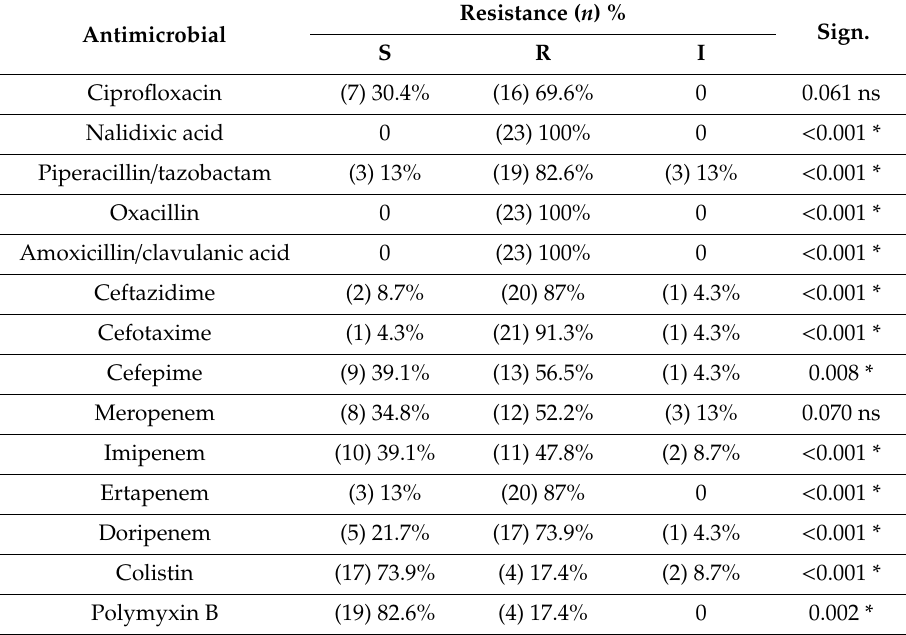
Figure 1. Random Amplification of Polymorphic DNA (RAPD) type, strain, source, carbapenemases, antimicrobial susceptibility, and MHT test of the 23 A. baumannii isolates. Individual isolates showing hierarchical clustering of isolates and factors. Binary factor (carbapenemase genes) indicated by presence (+) and absence (-); however, ordinal factor (antibiotics) indicating resistance by orange color, intermediate (yellow), and sensitive (green). Abbreviations: tobramycin (TOB), gentamycin (CN), amikacin (AK), norfloxacin (NOR), levofloxacin (LEV), ciprofloxacin (CIP), nalidixic acid (NA), ampicillin (AMP), piperacillin (PRL), amoxicillin/clavulanic acid (ATM), ceftazidime (CAZ), cefepime (FEP), cefotaxime (CTX), meropenem (MEM), imipenem (IPM), doripenem (DO), ertapenem (ETP), colistin (CT), and polymyxin B (PB).